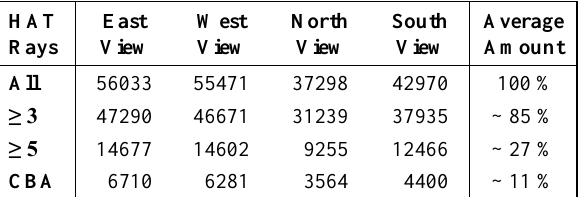
Table 6. Number of connection points used in different hierar- chical AT configurations in the Stillwater block.